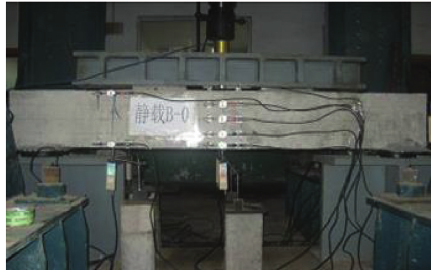
Figure 3: Static load test of the prestressed hollow